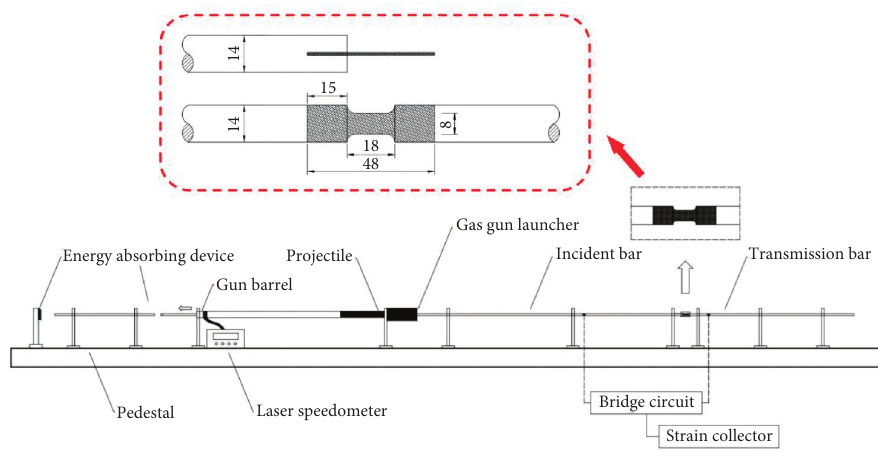
Figure 3: Diagram of the split Hopkinson bar test device.